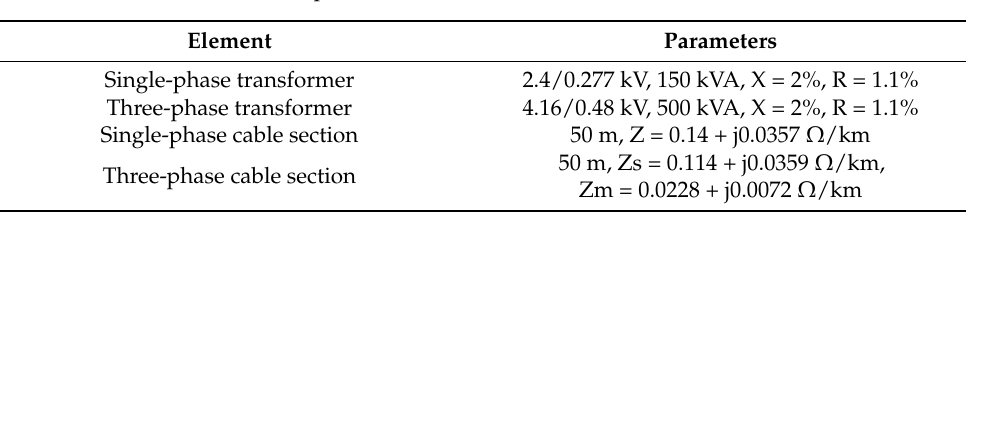
Table A1. Transformer and cable